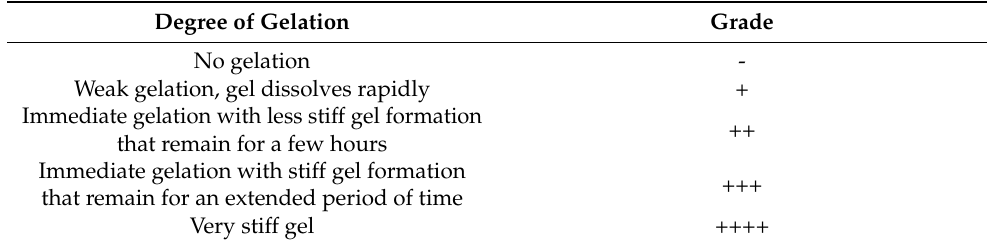
Table 2. Characterization of the grade of gelation. Degree of Gelation Grade No gelation